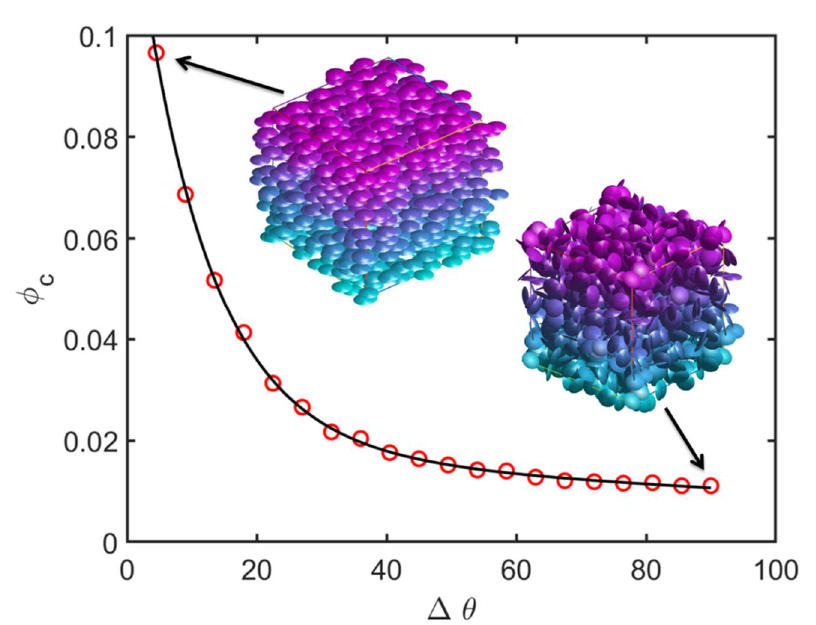
Figure 7. Percolation threshold ϕ c as a function of the degree of isotropy (0 = minimum, 90 = maximum) for simulated nanocomposites with nanofillers having an aspect ratio of 100.